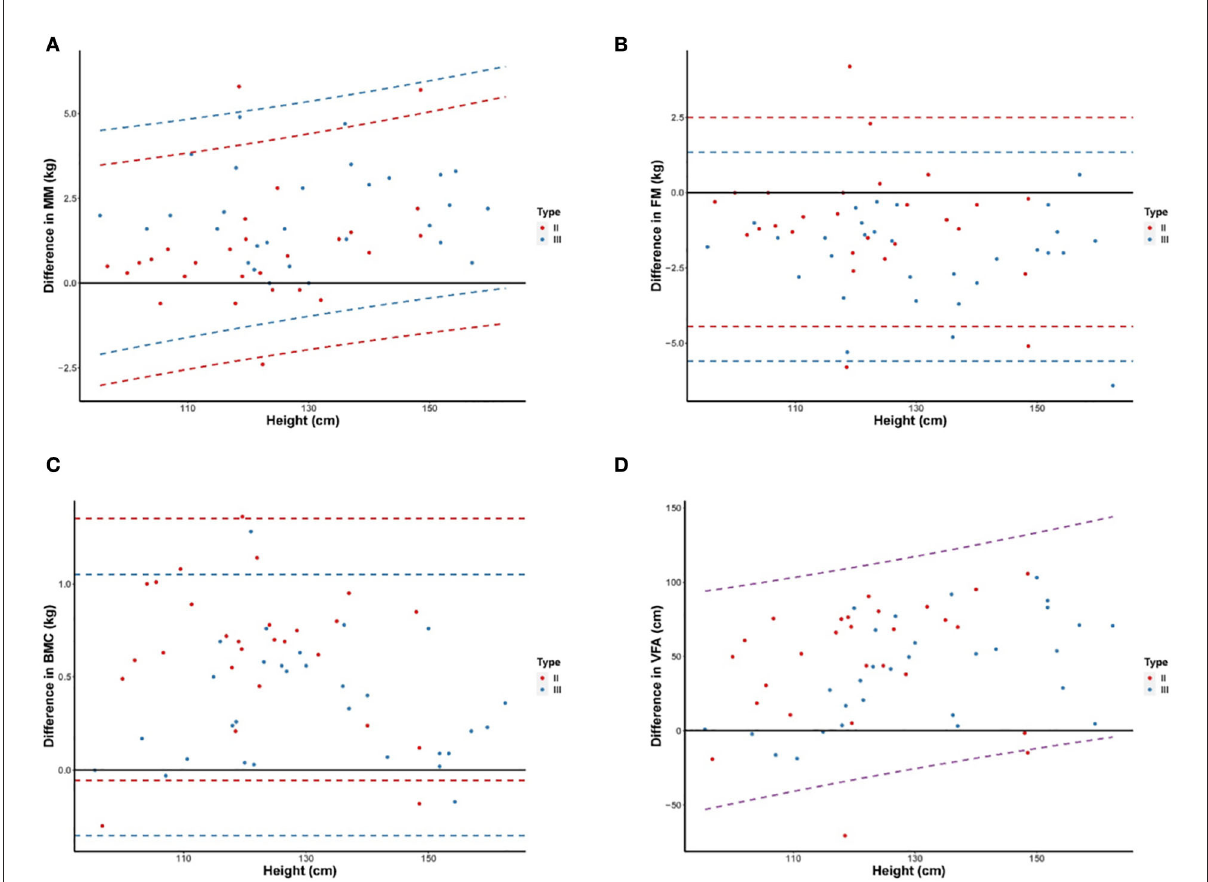
FIGURE3 Differences of MM (A) , FM (B) , BMC (C) , and VFA (D) measurements between DXA and BIA according to increasing height. Scatter plots and 95% LOA between the difference of values by DXA and BIA and height were shown for children with type II and III SMA. The difference in values is BIA minus DXA. The dashed line represents the 95% LOA of values, different colors were used to indicate children with type II (red), type III (blue), and all SMA (purple). FM, Fat mass; MM, Muscle mass; BMC, Bone mineral content; VFA, Visceral fat area; LOA, limits of